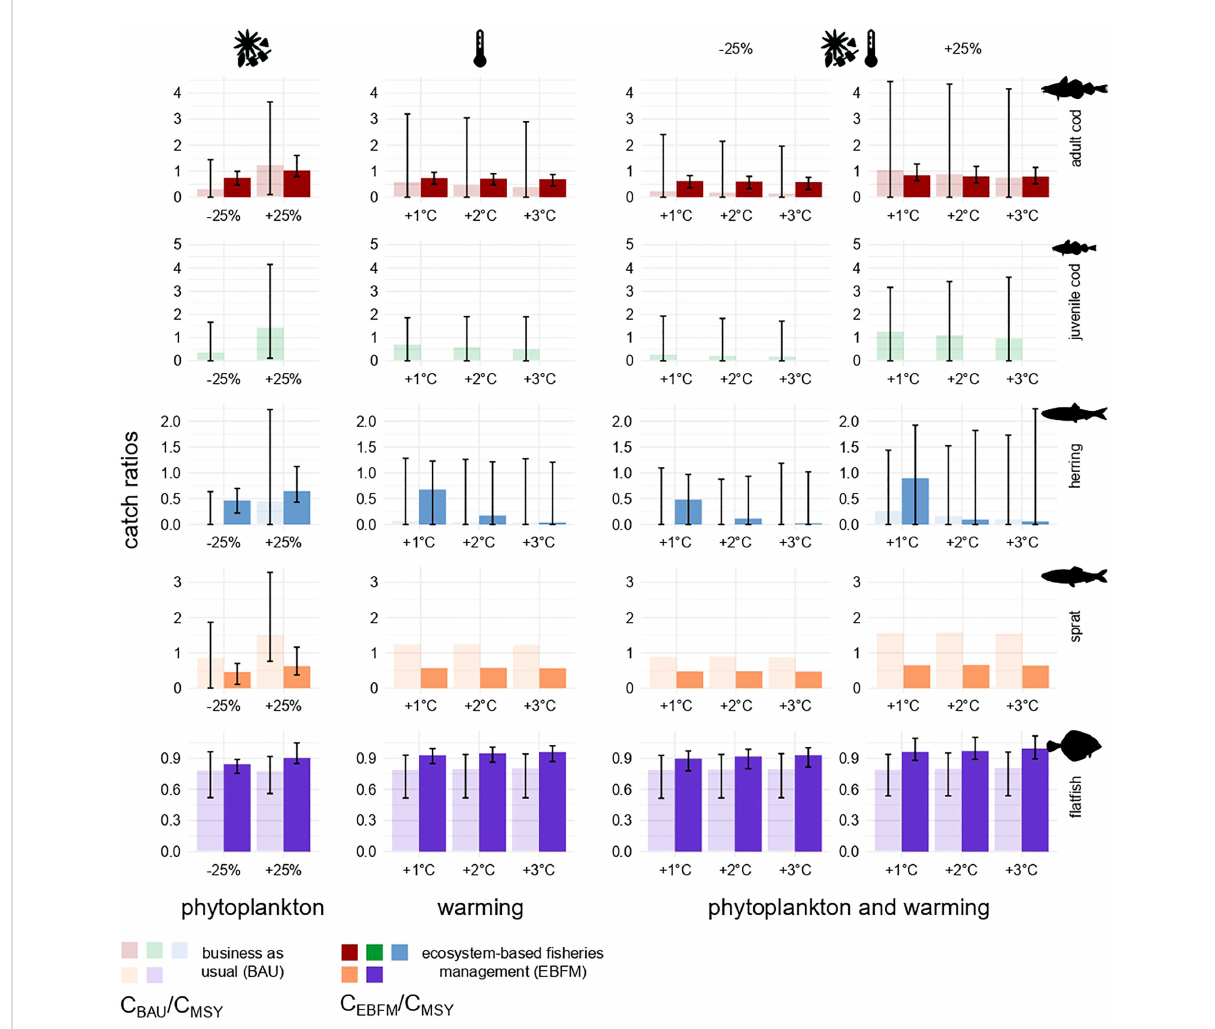
FIGURE 7 Catch ratios under the impact of fi sh extraction plus phytoplankton biomass change, ocean warming, or all factors in combination. Each bar illustrates the ratio between the catch under BAU (transparent) or EBFM (opaque) and F MSY catch, all quanti fi ed using reference runs. Ratios equal to 1 indicate the C MSY level. Catches were computed as the average of values estimated for the last 20 years of each simulation (2081- 2100). Error bars were built using the corresponding Monte Carlo randomizations and show 2% and 98% percentiles as lower and upper bounds, respectively. Under all warming scenarios, sprat bar plots do not have error bars because its stock biomass was used as forcing